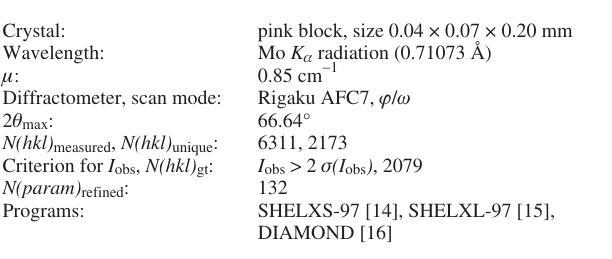
Table 1. Data collection and